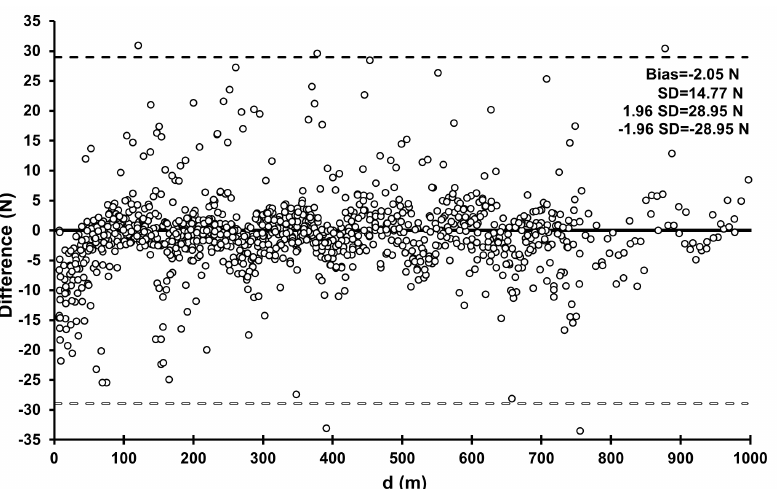
Figure 4. Dispersion between the measured and modelled pedal force F T as a function of the distance travelled for all runs measured. Black lines indicate upper and lower limits of the 95%- confidence